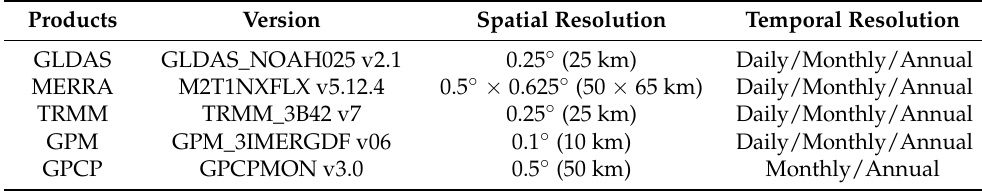
Table 2. Spatial and temporal resolutions and versions of each of the precipitation products used over the state of Mato Grosso,